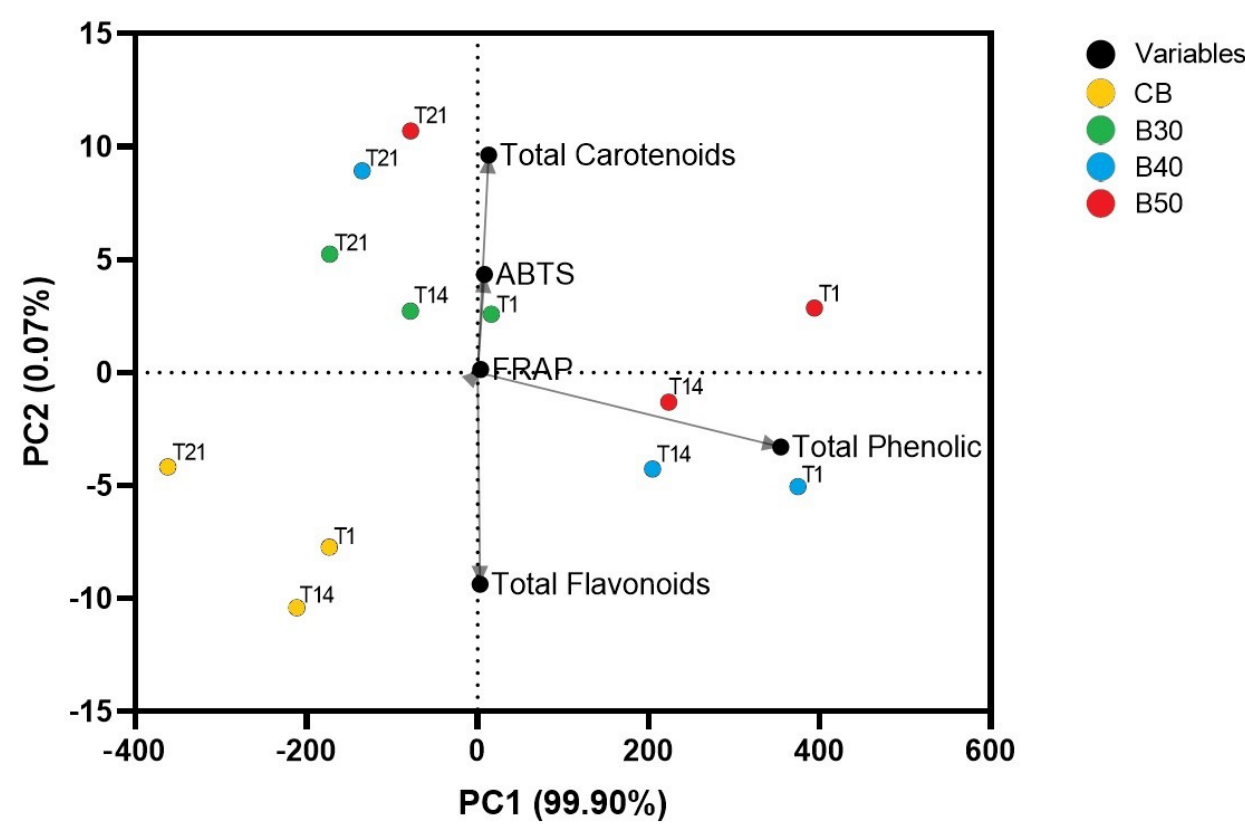
Figure 3. Principal Component Analysis of contents of total carotenoids, total flavonoids and total phenolic compounds and